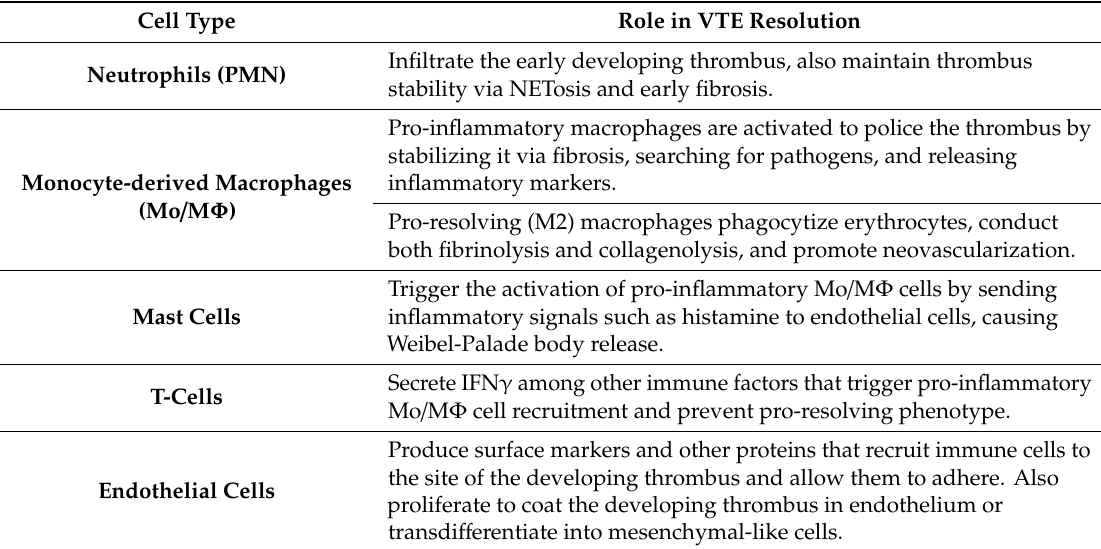
Table 1. Primary cellular types and roles in venous thrombus